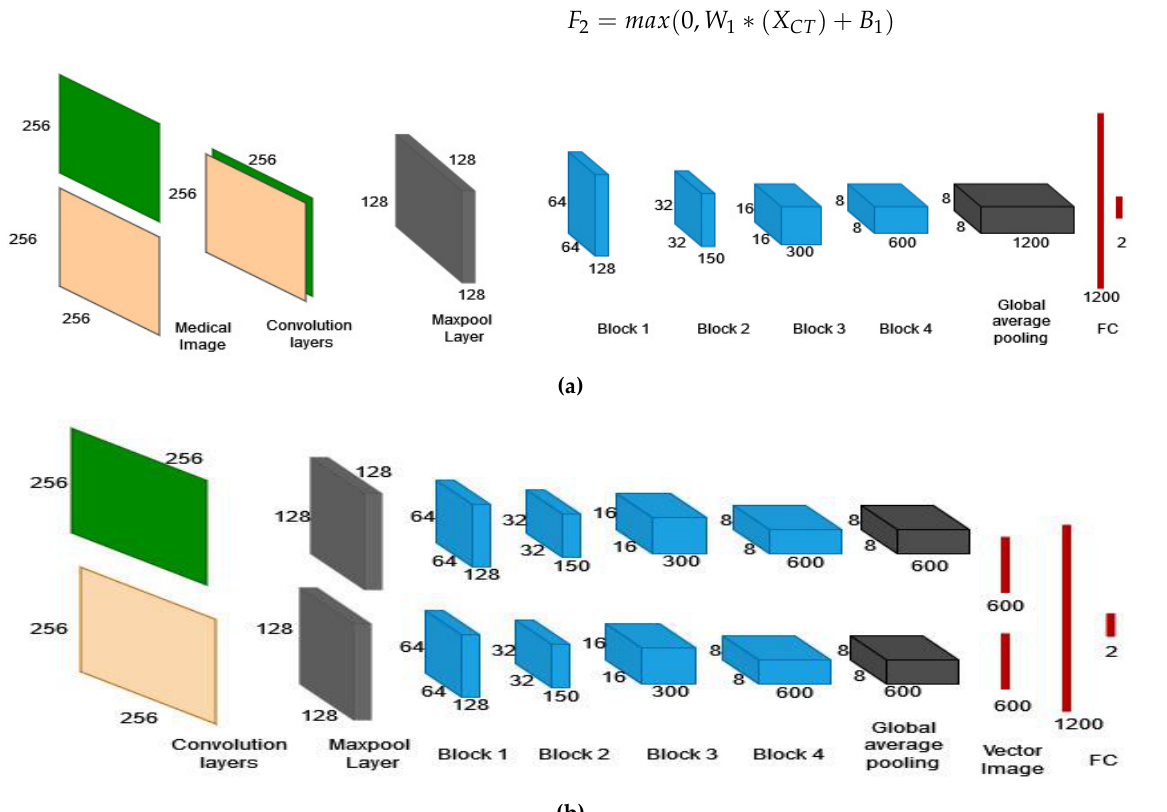
Figure 3. (a), (b). Proposed fusion network based on deep learning convolutional neural networks. Figure 3. Fusion network based on deep learning convolutional neural networks. ( a ) Generalised fusion network for medical images fusion, ( b ) Proposed method of fusion